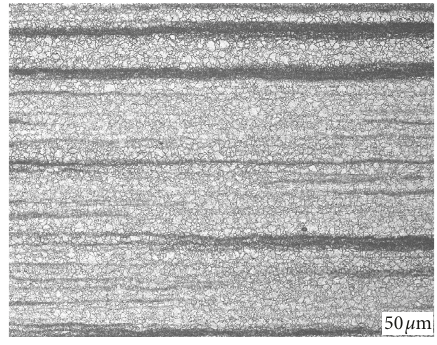
Figure 5: Grain size of bolt matrix.